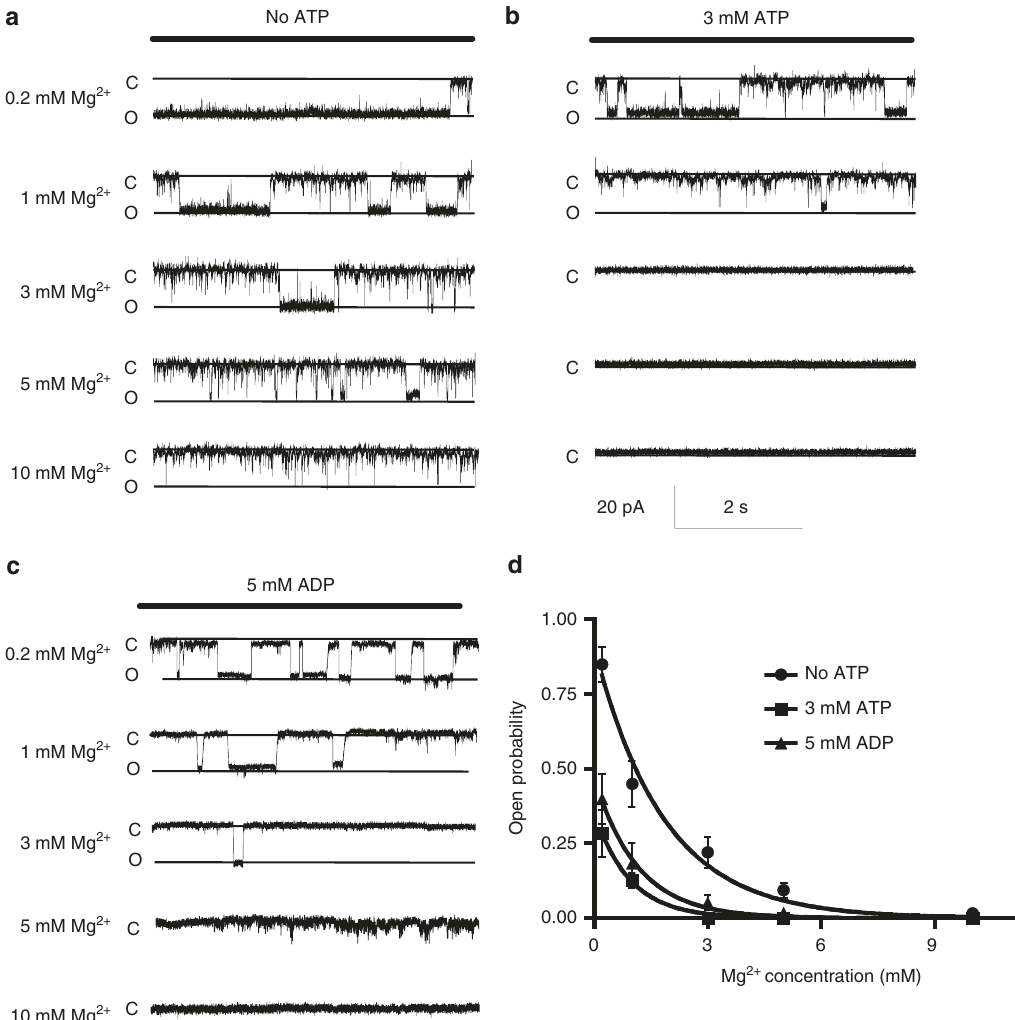
Fig. 2 Patch clamp analyses of the MgtE-nucleotide complexes. a – c The MgCl 2 concentration in the bath was increased from 0.2 to 10 mM, and single currents were measured at each MgCl 2 concentration for wild type MgtE-reconstituted GUVs with b ATP, c ADP, and without a nucleotide. Representative current traces recorded at − 120 mV from a single membrane patch at different [Mg 2+ ] in are shown. ( d ) The open probabilities at different [Mg 2+ ] with and without nucleotide were calculated ( Bars represent ± SEM, n = 5 for each condition). The Hill coef fi cients for apo, ATP, and ADP are 0.3, 1.0, and 0.4,